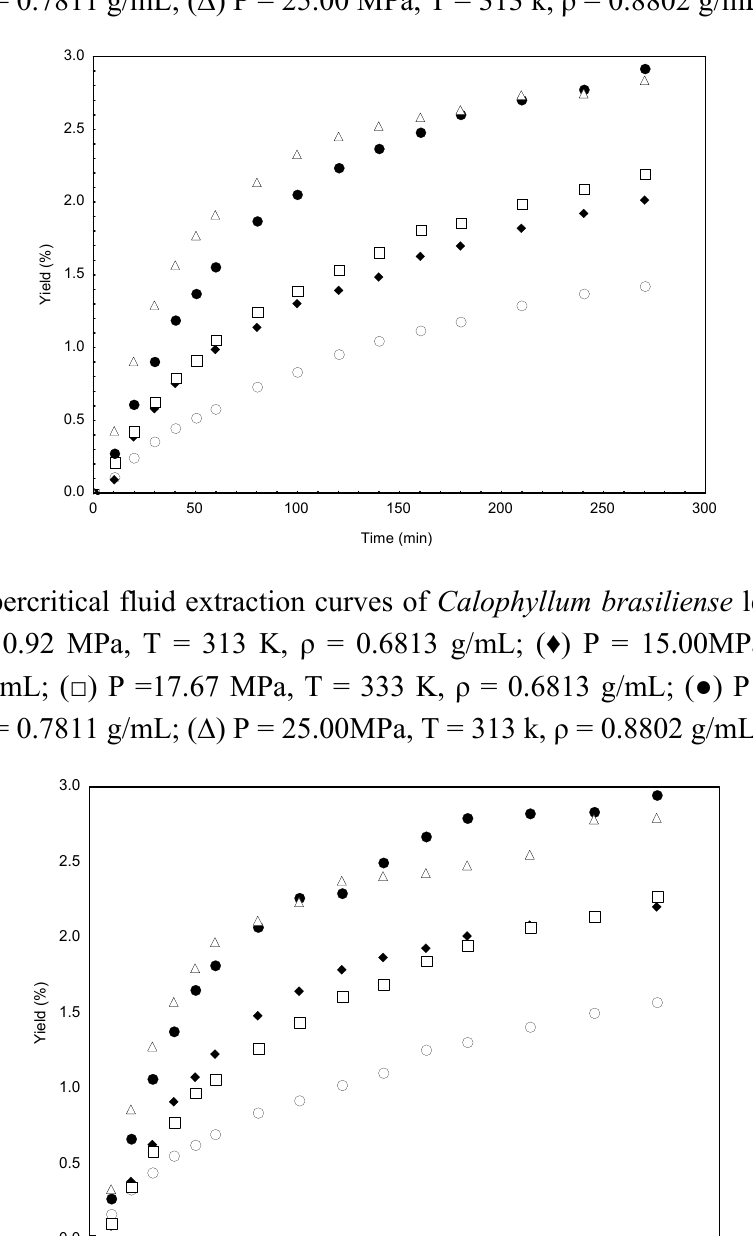
Figure 1. Supercritical fluid extraction curves of Calophyllum brasiliense leaves by mesh 30. ( ○ ) P = 10.92 MPa, T = 313 K, ρ = 0.6813 g/mL; ( ♦ ) P = 15.00MPa, T = 313 K, ρ = 0.7811 g/mL; ( □ ) P =17.67 MPa, T = 333 K, ρ = 0.6813 g/mL; ( ● ) P = 24.41 MPa, T = 333 K, ρ = 0.7811 g/mL; ( ∆ ) P = 25.00 MPa, T = 313 k, ρ = 0.8802 g/mL.